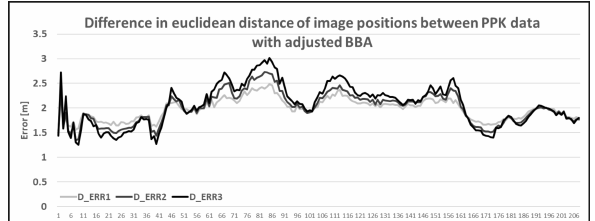
Figure 11. The difference in euclidean distance of image positions between post processed PPK GNSS and after adjusted BBA.